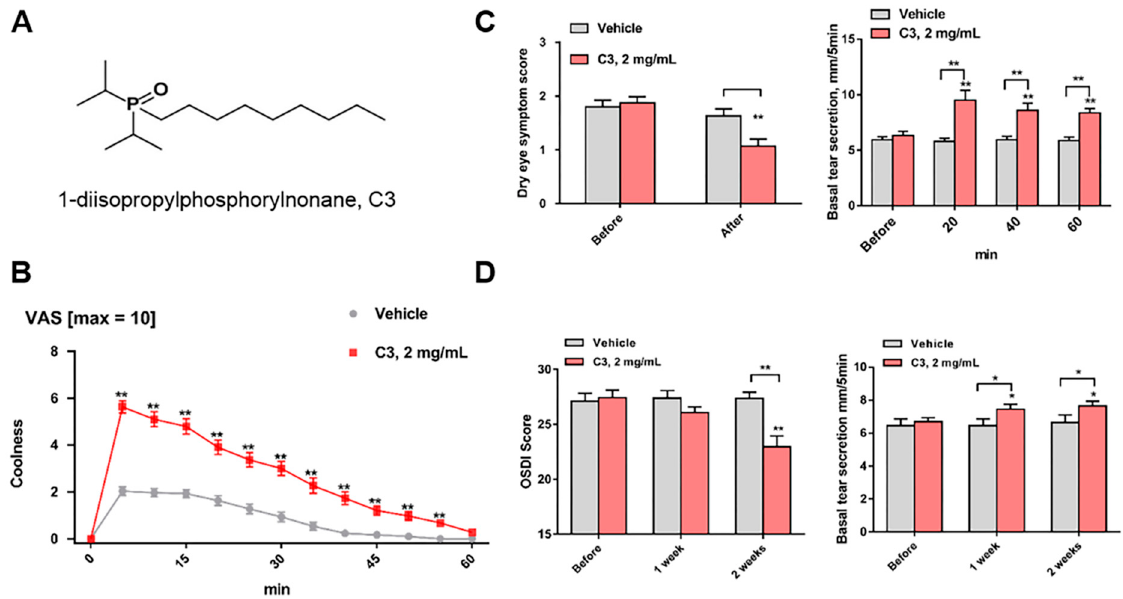
Figure 2. Chemical structure and function of C3. ( A ) Structure of 1-diisopropylphosphorylnonane, cryosim-3 (C3). ( B , C ) Visual analogue scale (VAS), ( B ) dry eye symptom score, and basal tear secretion ( C ) after single application of vehicle or C3. ( D ) Ocular surface disease index (OSDI) score, and basal tear secretion after application of vehicle of C3 four times a day for 2 weeks. * P < 0.05, ** P < 0.01, compared to baseline value or vehicle (Adapted from Yang et al. [12]).